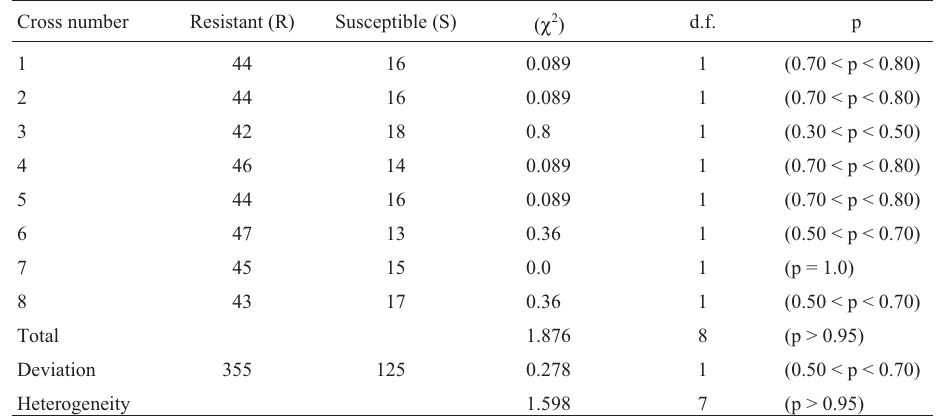
Table IV - Results of the heterogeneity test applied to the values obtained from the second evaluation of plant resistance to powdery mildew. Cross